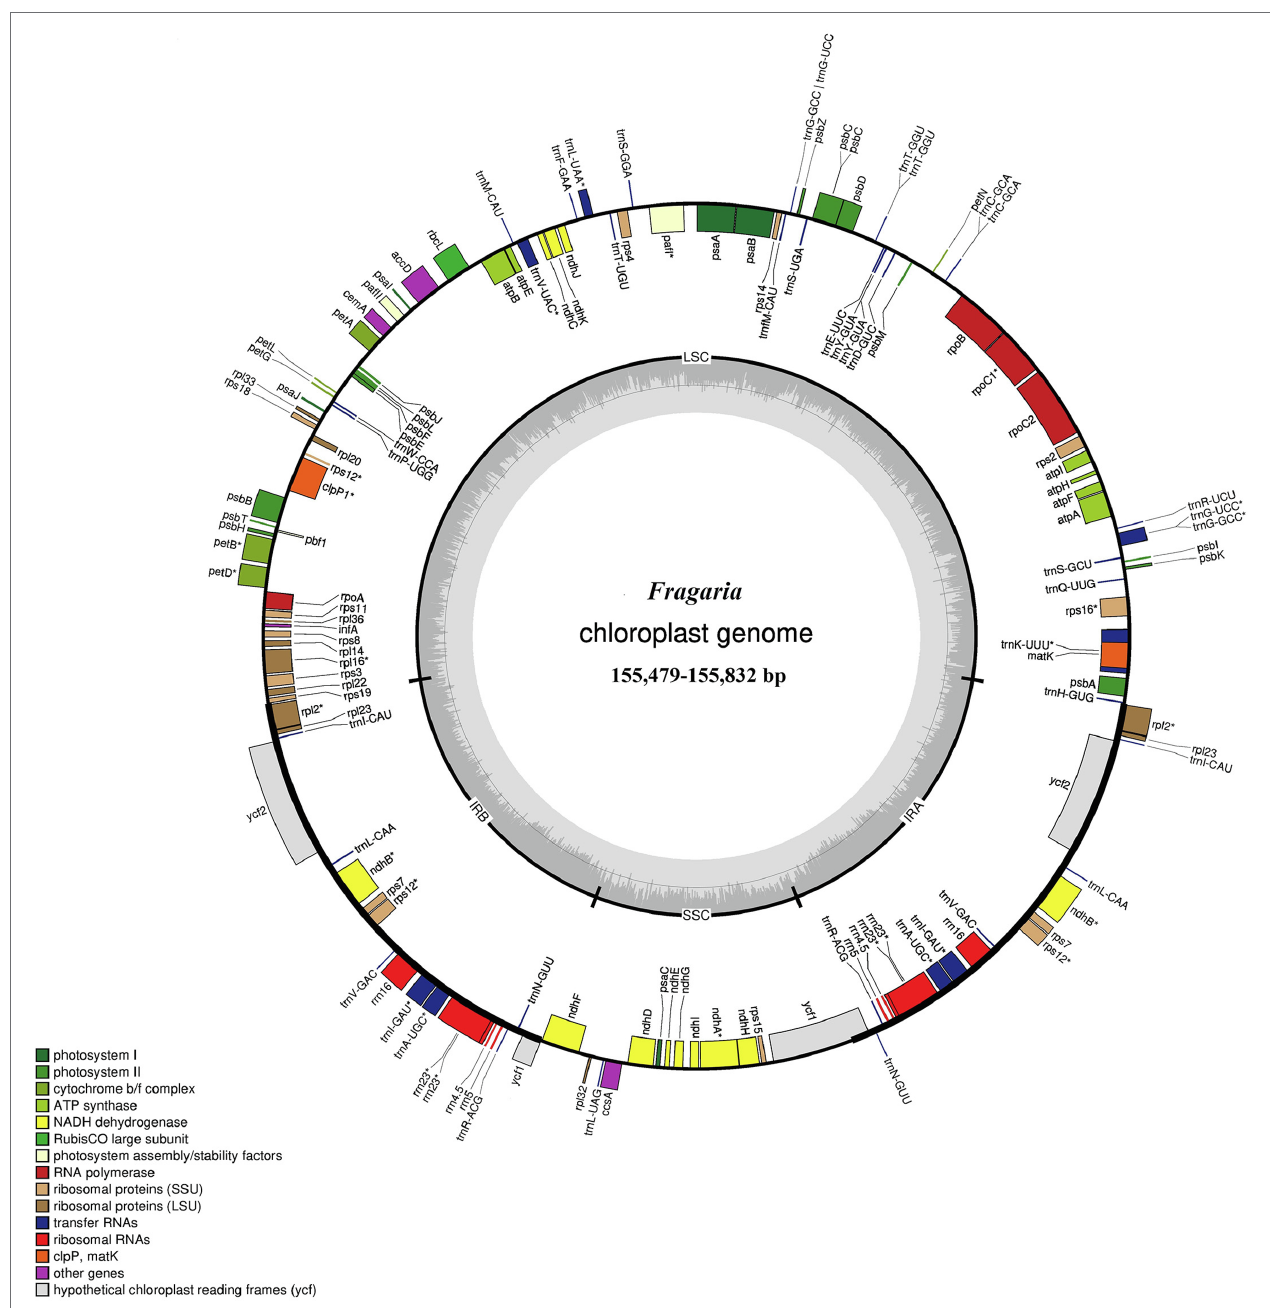
FIGURE 1 | Gene map of the Fragaria chloroplast genome. Genes drawn inside the circle are transcribed clockwise, and those outside are transcribed counter clockwise. Color coding is used to show genes belonging to different functional groups. The inner circle indicates the range of the long single-copy region (LSC), short single-copy region (SSC), and inverted repeat regions (IRs) and also shows a GC content graph of the genome. In the GC content graph, the dark gray lines indicate GC content, while light gray lines indicate the AT content of each